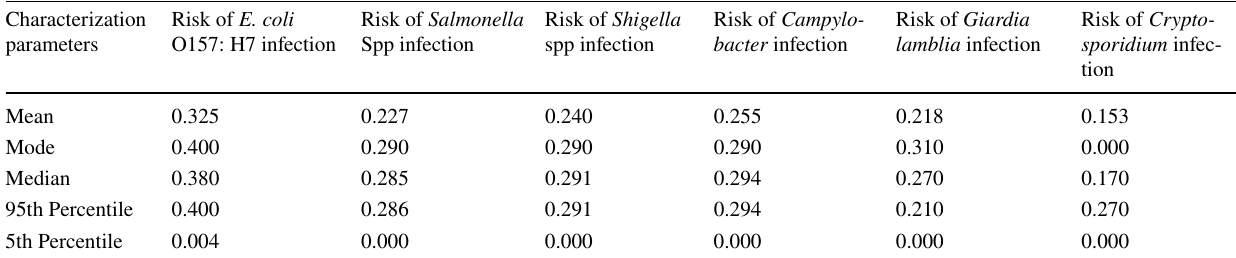
Table 11 Risk of pathogen infection characterization Characterization parameters